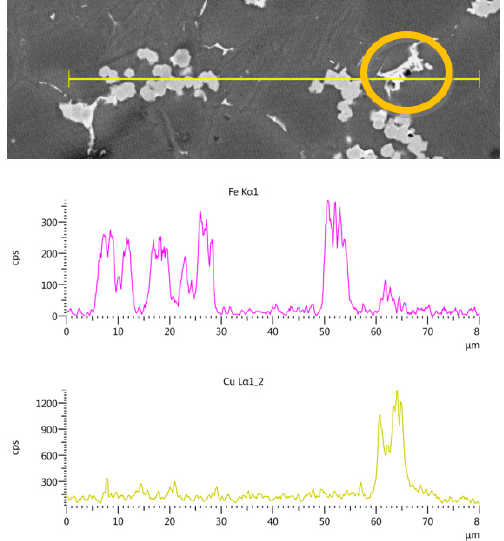
Figure 14. Line EDS analysis of Cu inter-metallic—SB 55 with v max = 4 m.s − 1 .